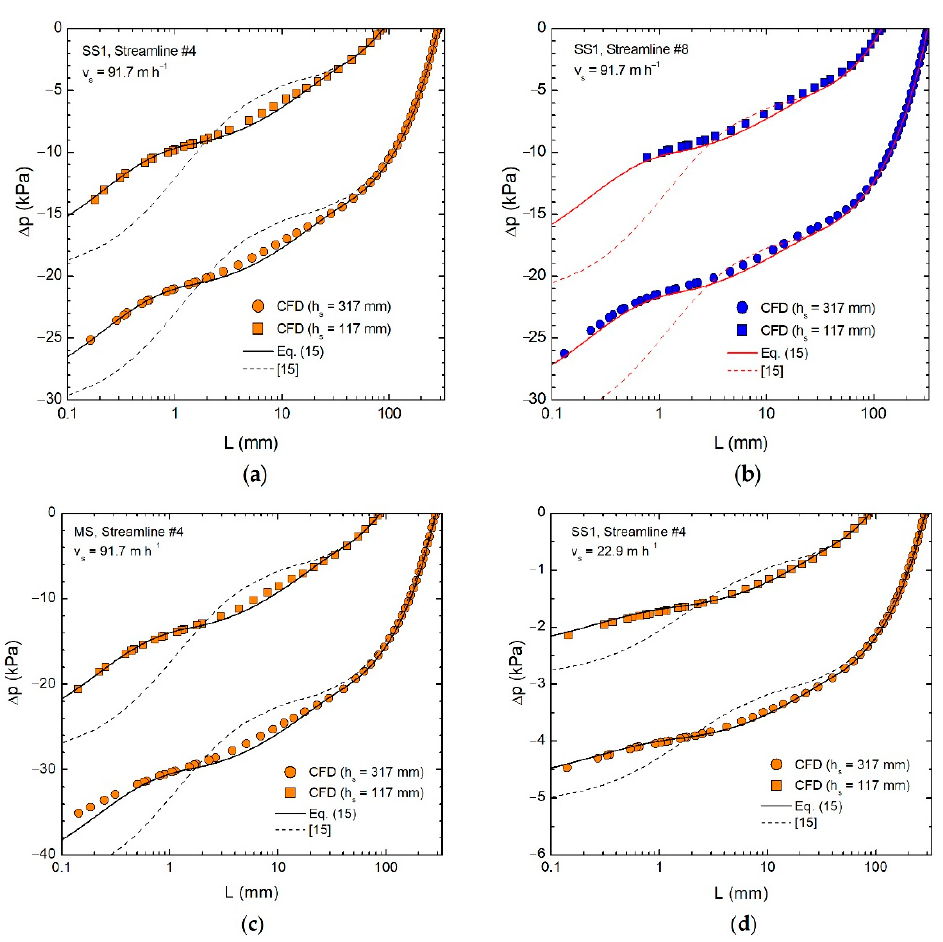
Figure 13. Pressure variation along streamlines ( a , c , d ) #4 and ( b ) #8 of Figure 11 simulated (symbols), predicted by the analytical Equation (15) (solid line) and predicted by the analytical equation in [15] (dashed line) for two different heights of the packed bed h s . Cases with momentum sink term as for Ergun with 𝑄 = 0.8 L s − 1 and SS1 media type ( a , b ), 𝑄 = 0.2 L s − 1 and SS1 media type ( c ) and 𝑄 = 0.8 L s − 1 and MS media type ( d ). Slots are located at 𝐿 = 0 mm.